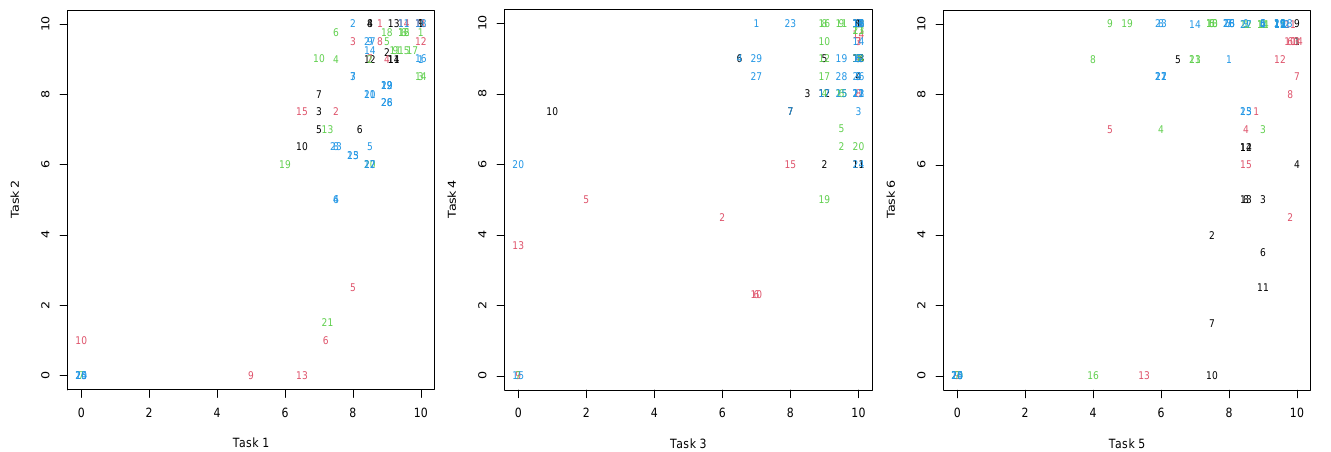
Figure 3. Illustration of the grades of the different groups in the academic periods 2017/18 (black), 2018/19 (red), 2019/20 (green) and 2020/21 (blue). Grades of Tasks 1 and 2 in the left plot, of Tasks 3 and 4 in the central plot and of Tasks 5 and 6 in the right plot. Each group in an academic period is labeled by a corresponding